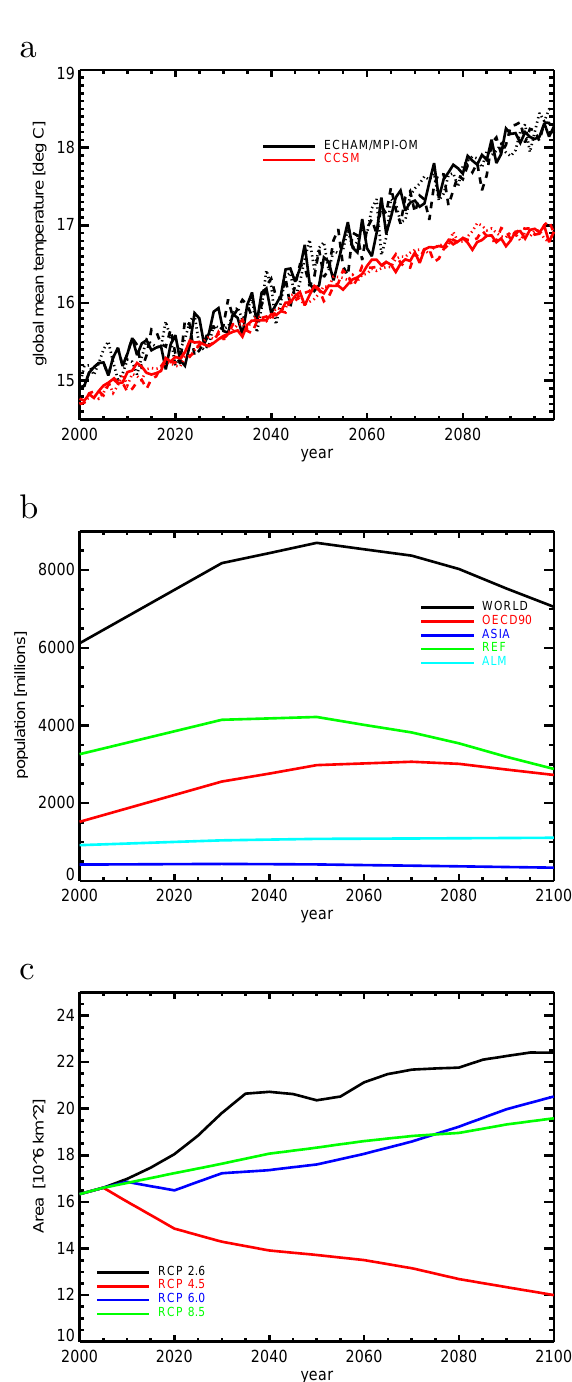
Fig. 1. Forcing factors applied in this study. (a) Climate – global annual mean surface temperature in [deg C] as simulated with ECHAM/MPI-OM (Roeckner et al., 2006) and CCSM (Meehl et al., 2006). Both models applied the IPCC A1B SRES scenario forcing (Nakicenovic et al., 2000). For each model three ensemble simula- tions are shown. (b) Population – total population for the IPCC A1B SRES scenario for the SRES regions and the global total (CIESIN, 2002). (c) Land use change – global total crop area for the different